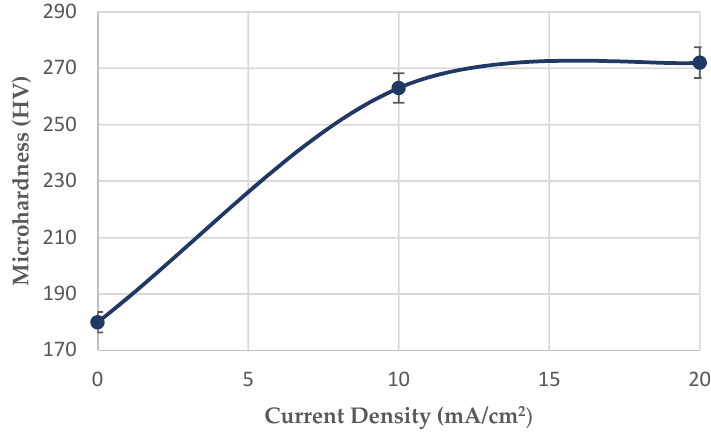
Figure 5. Effect of the applied current density (10 and 20 mA/cm 2 ) during the in situ hydrogen cathodic charging process and bending loading on the surface microhardness increment.